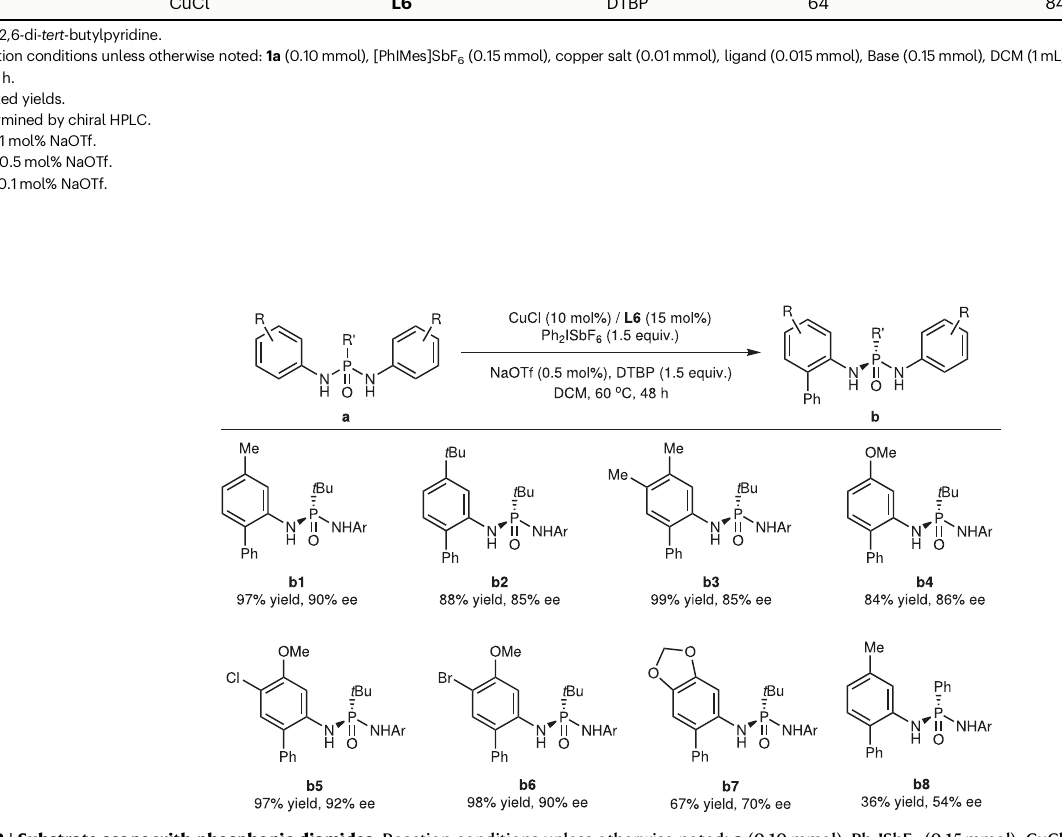
Fig. 2 | Substrate scope with phosphonic diamides. Reaction conditions unless otherwise noted: a (0.10mmol), Ph 2 ISbF 6 (0.15mmol), CuCl (0.01mmol), L6 (0.015mmol), NaOTf (0.0005mmol), DTBP (0.15mmol), DCM (2mL) in a sealed tube at 60°C for 48h. DTBP 2,6-di- tert